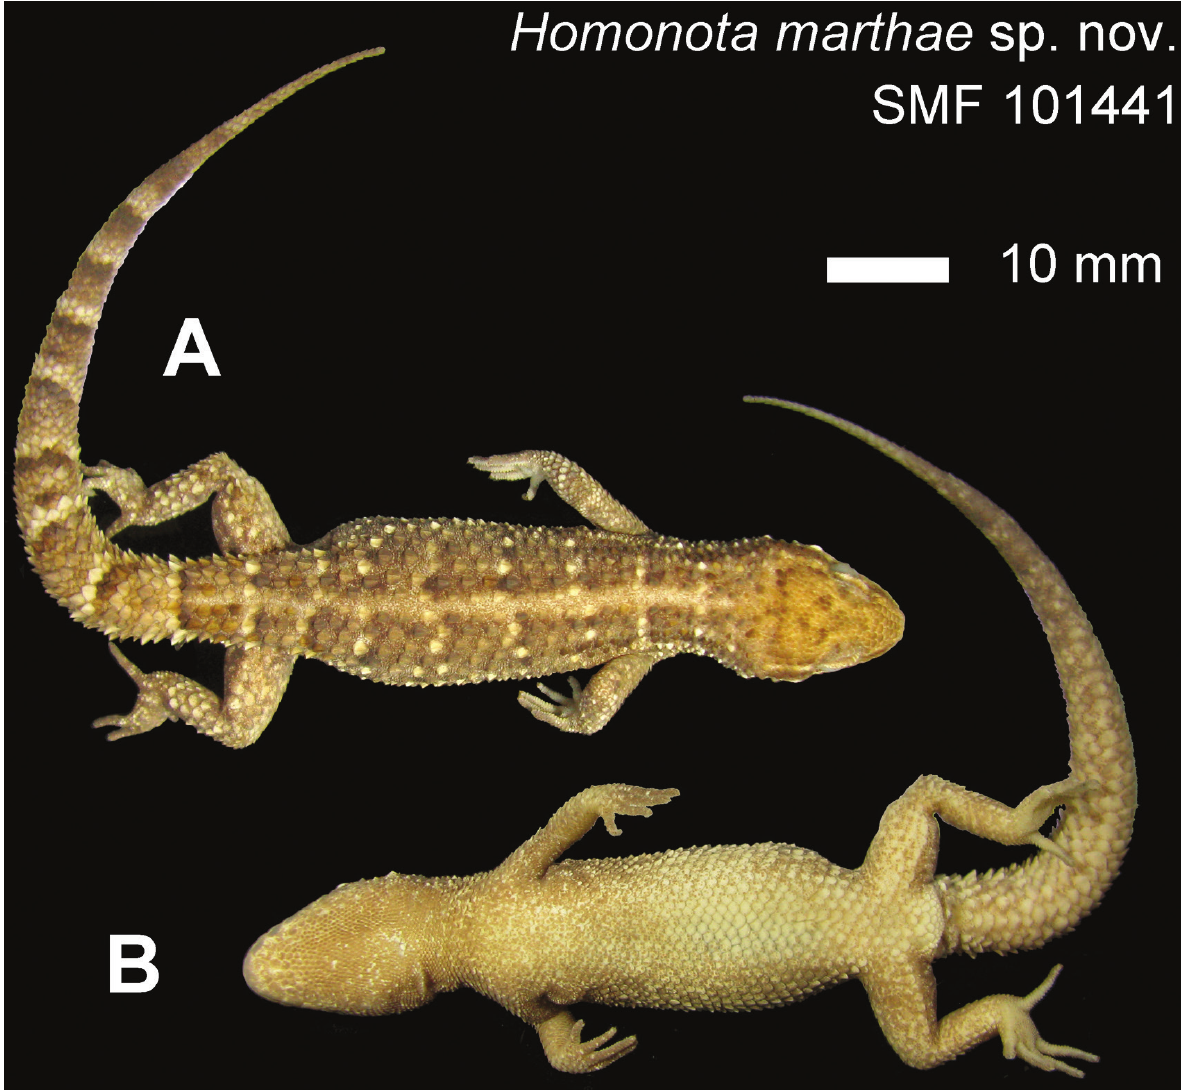
Figure 4. Dorsal ( A ) and ventral ( B ) views of the holotype of Homonota marthae